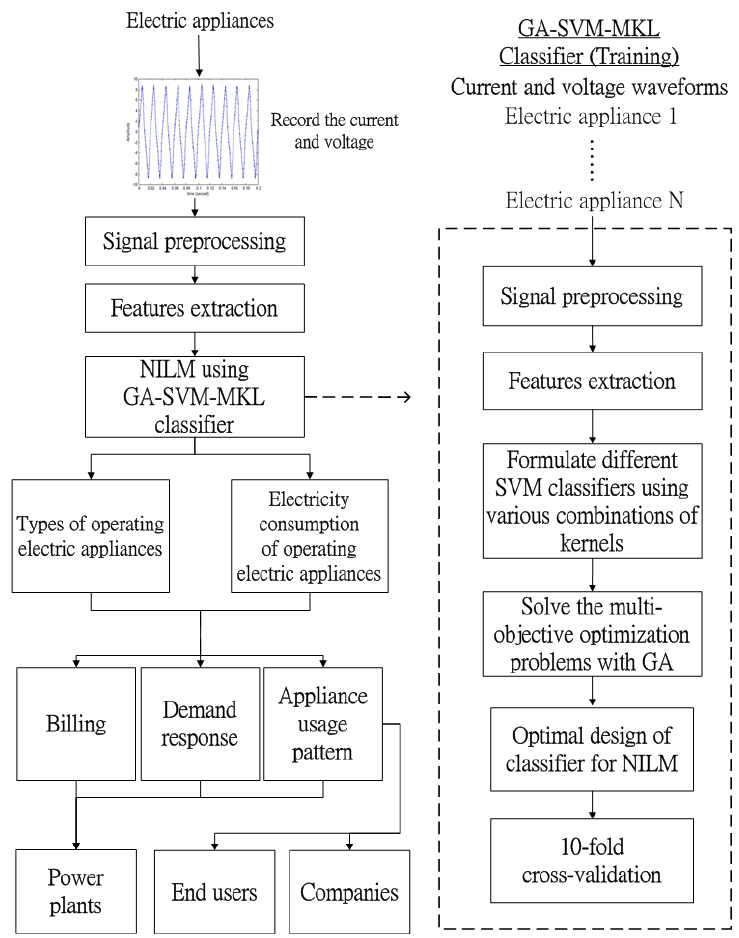
Figure 3. Flow chart for the operation of generic algorithm support vector machine multiple kernel learning (GA-SVM-MKL) classifier for NILM.